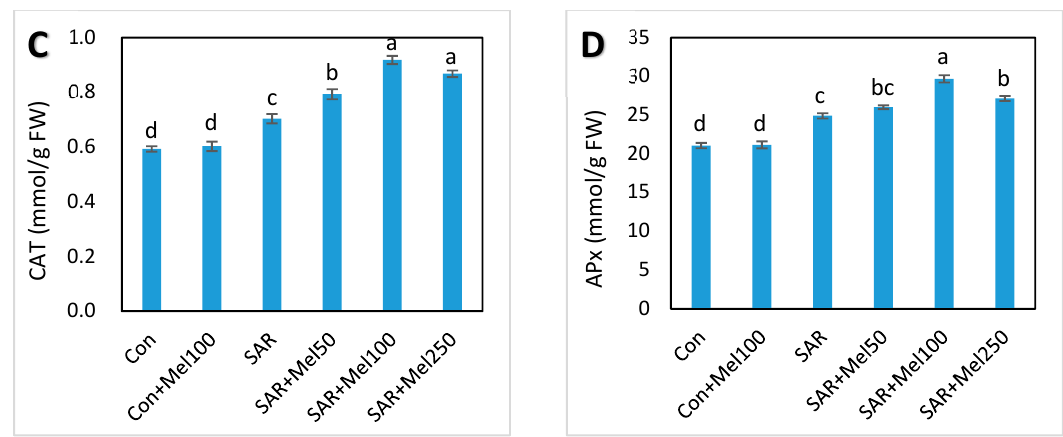
Figure 6. Changes of enzymatic antioxidant activities in tomato leaves by SAR and/or melatonin treatments. ( A ) SOD; ( B ) POD; ( C ) CAT; ( D ) APx. Data indicates here the mean of four replications. Vertical bars indicate the standard error. Means not sharing a common letter within the graph are significantly different at p ≤ 0.05 according to Tukey’s test.